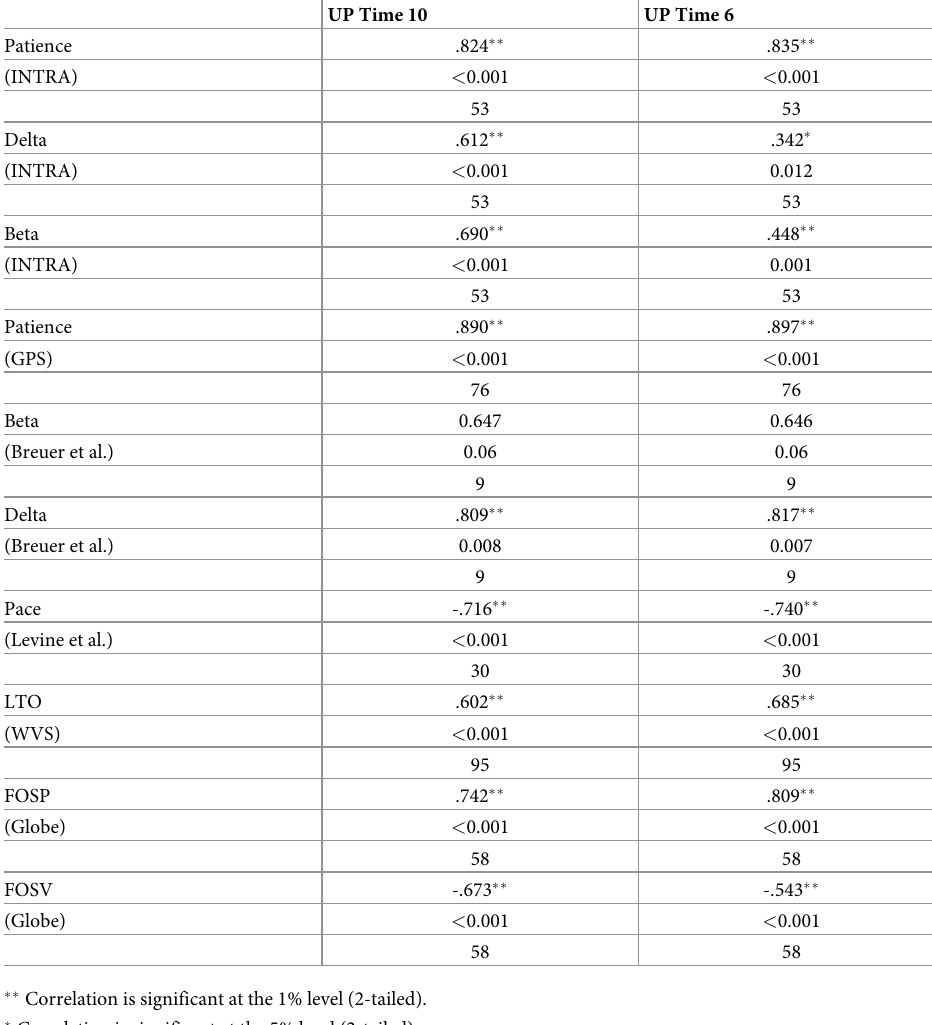
Table 4. Correlations of the UP time variables with previous